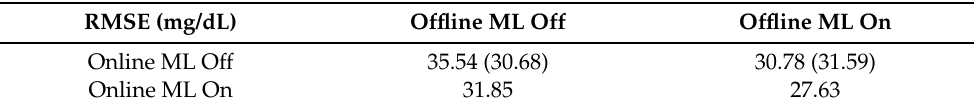
Table 2. The summary of results for the BGL prediction task with the non-stationary target profile varying between adult#001 and adult#003. Numbers in the brackets are from the model without the sliding window, and the others are with the sliding window (length = 576). ML denotes meta-learning. RMSE (mg/dL) Offline ML Off Offline ML On Online ML Off 35.54 (30.68) Online ML